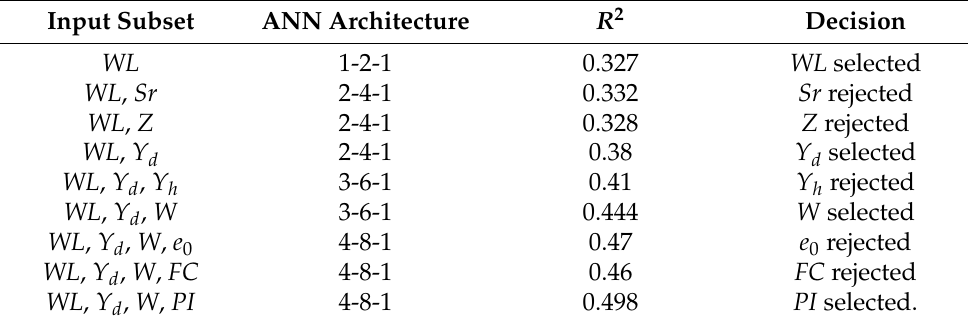
Table 9. Results of forward selection procedure of different input